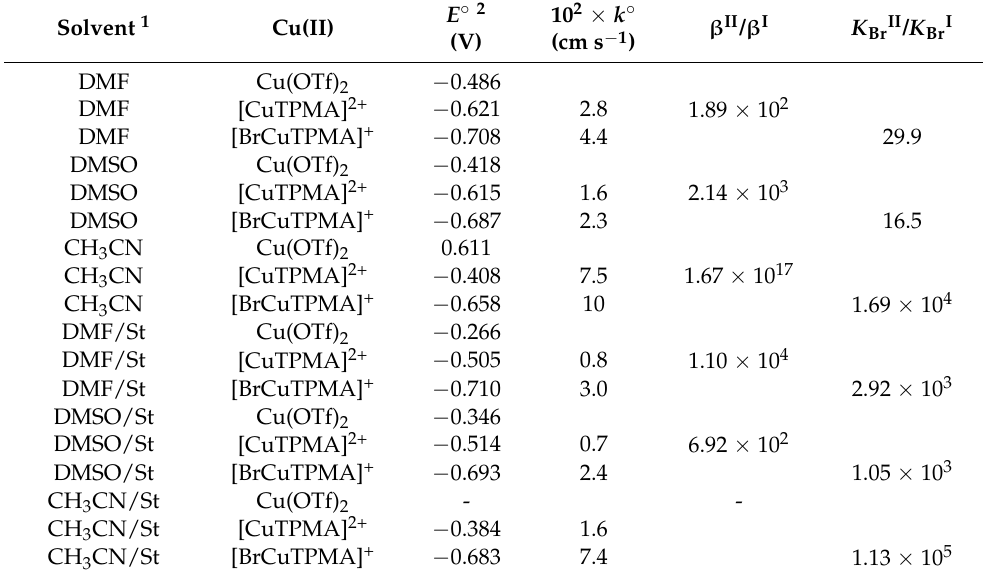
Table 1. Redox properties of copper complexes and their relative stabilities in different media at 25 °C.